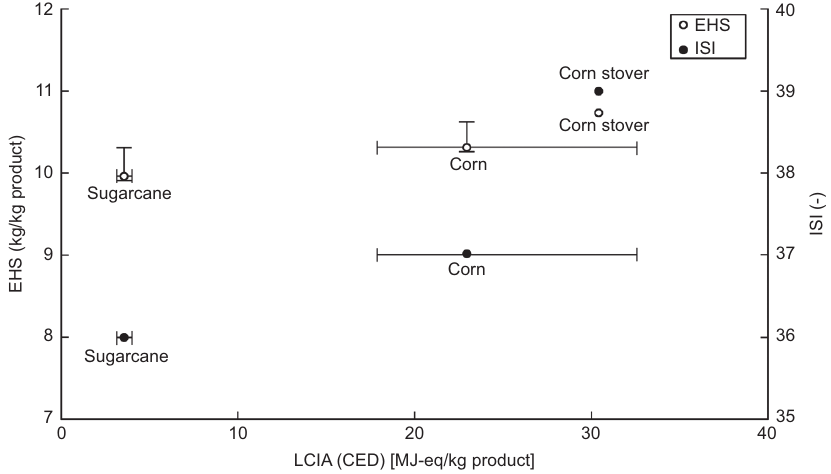
Figure 5 Hazard (EHS and ISI) vs. LCIA depicted by CED [LCIA (CED)]. The EHS and the ISI results refer to the base case analysis considering the different process sections, whereas the CED values are collected from various literature sources as expressed by the respective error bars (the exact values are reported in the Supporting Information). The error bars for the EHS method show the impact of different feedstock composition and process conditions, whereas the ISI scores are not affected (CED for conventional ethanol: 48 MJ-eq/kg product